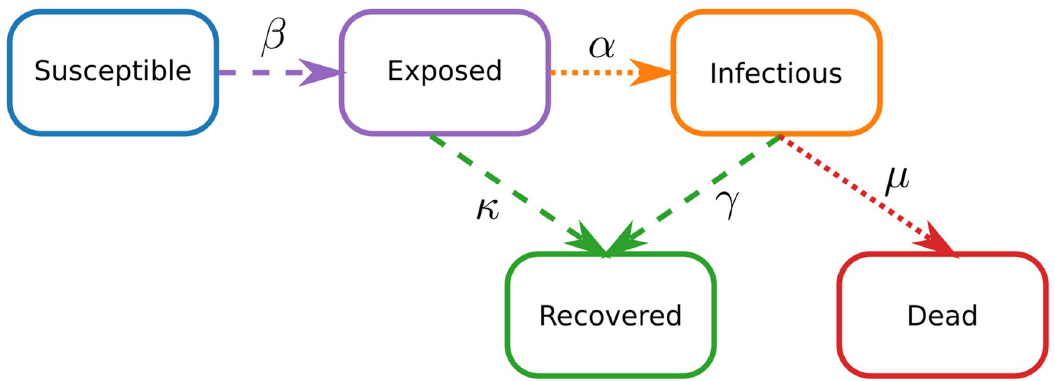
Fig 1. The model structure. A visual representation of Eqs (1)–(5), with the different compartments shown as boxes and the transfer rates as arrows. The data gathered by the RKI are shown as dotted arrows, instead of dashed ones. The color coding of the different compartments is kept consistently throughout this